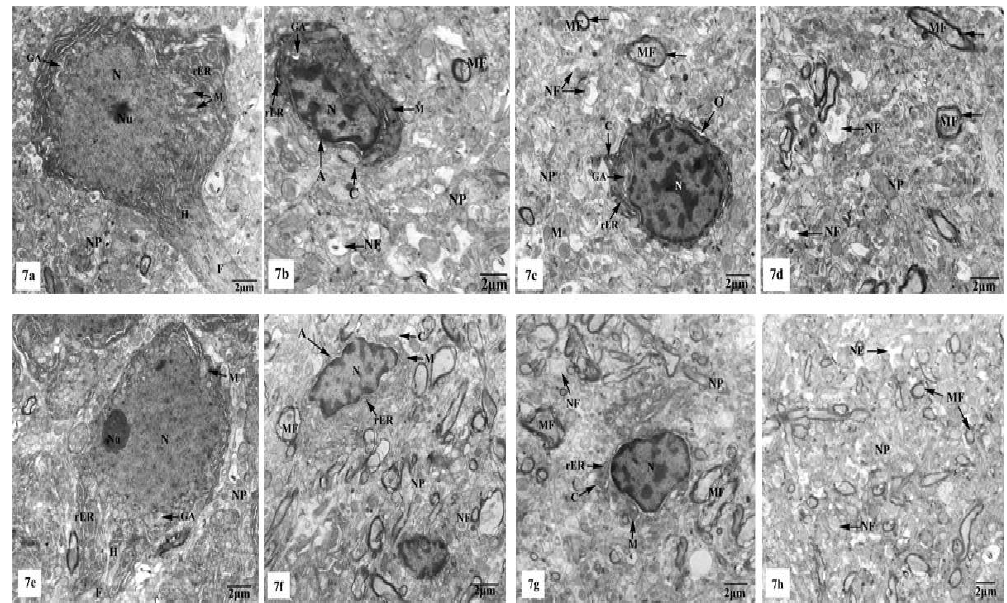
Figure 7. Electron micrographs of the hippocampal CA1 subfields of control ( a – d ) and SM-treated